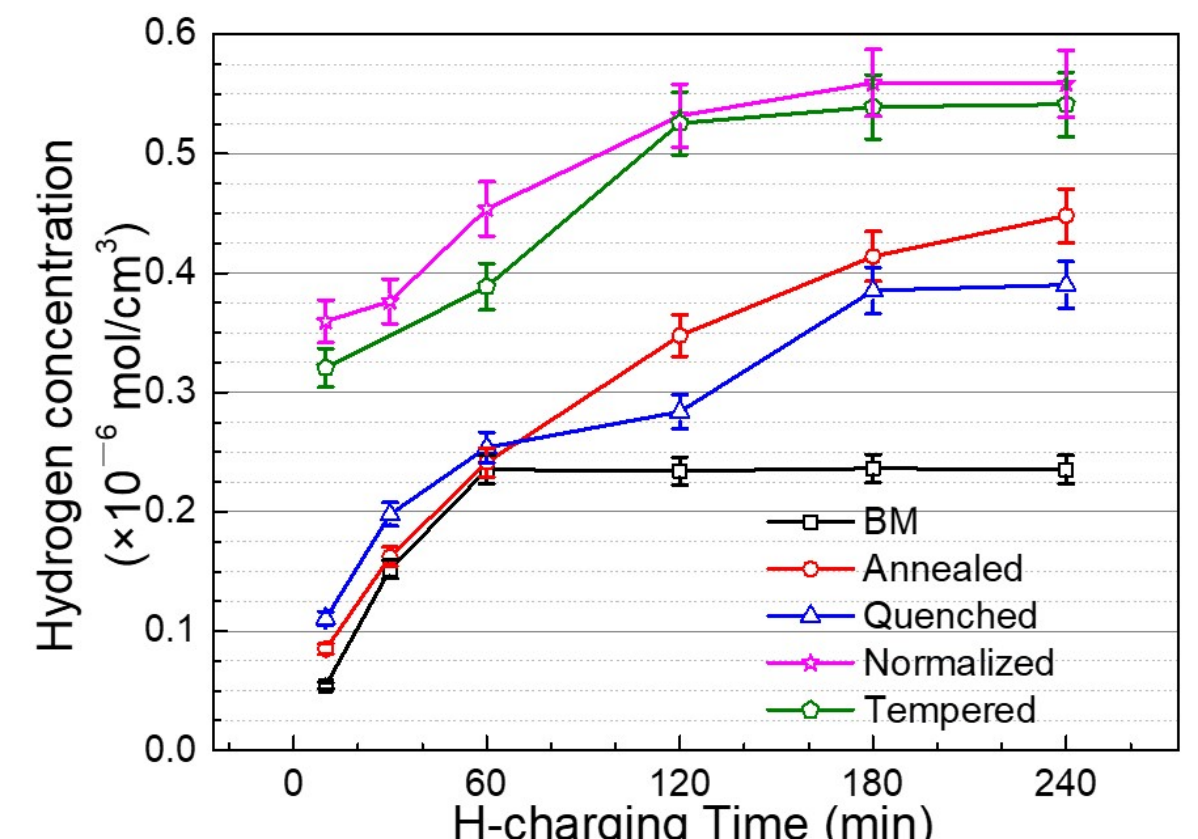
Figure 11. The absorbed H concentration released during potentiostatic hydrogen discharging ( − 0.9 V (vs. Ag/AgCl)) as a function of hydrogen charging time for the steel with different microstructures.